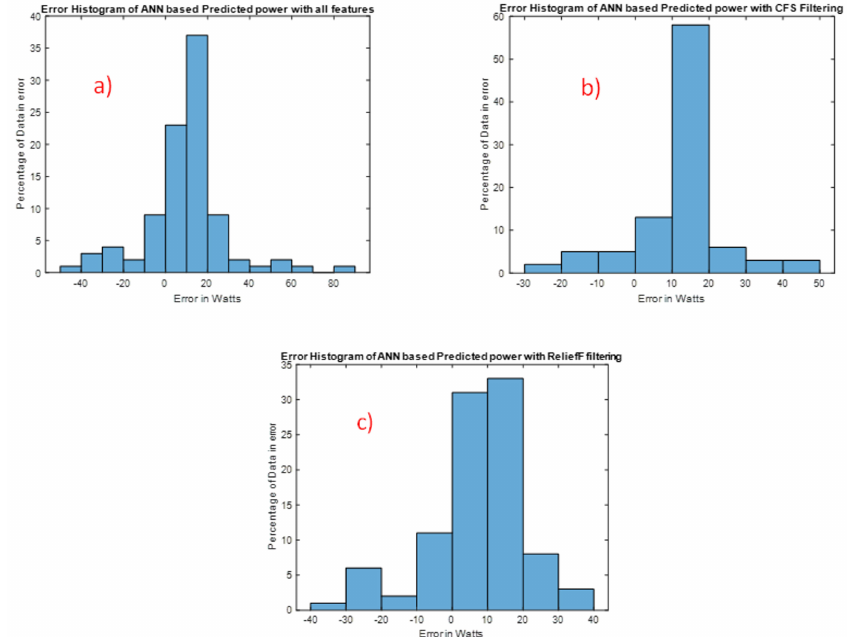
Figure 10. Error Histogram between the Predicted and actual PV with test dataset: ( a ) With all features; ( b ) CFS feature selection technique; ( c ) ReliefF feature selection